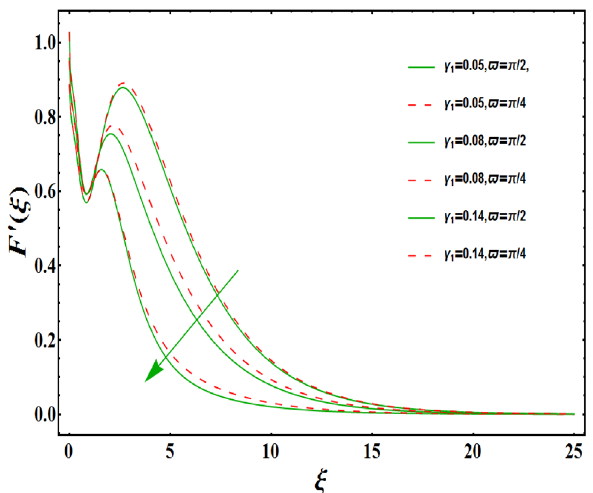
Figure 11. Variation of γ 1 on F ′ (ξ) for both with and without inclanation.